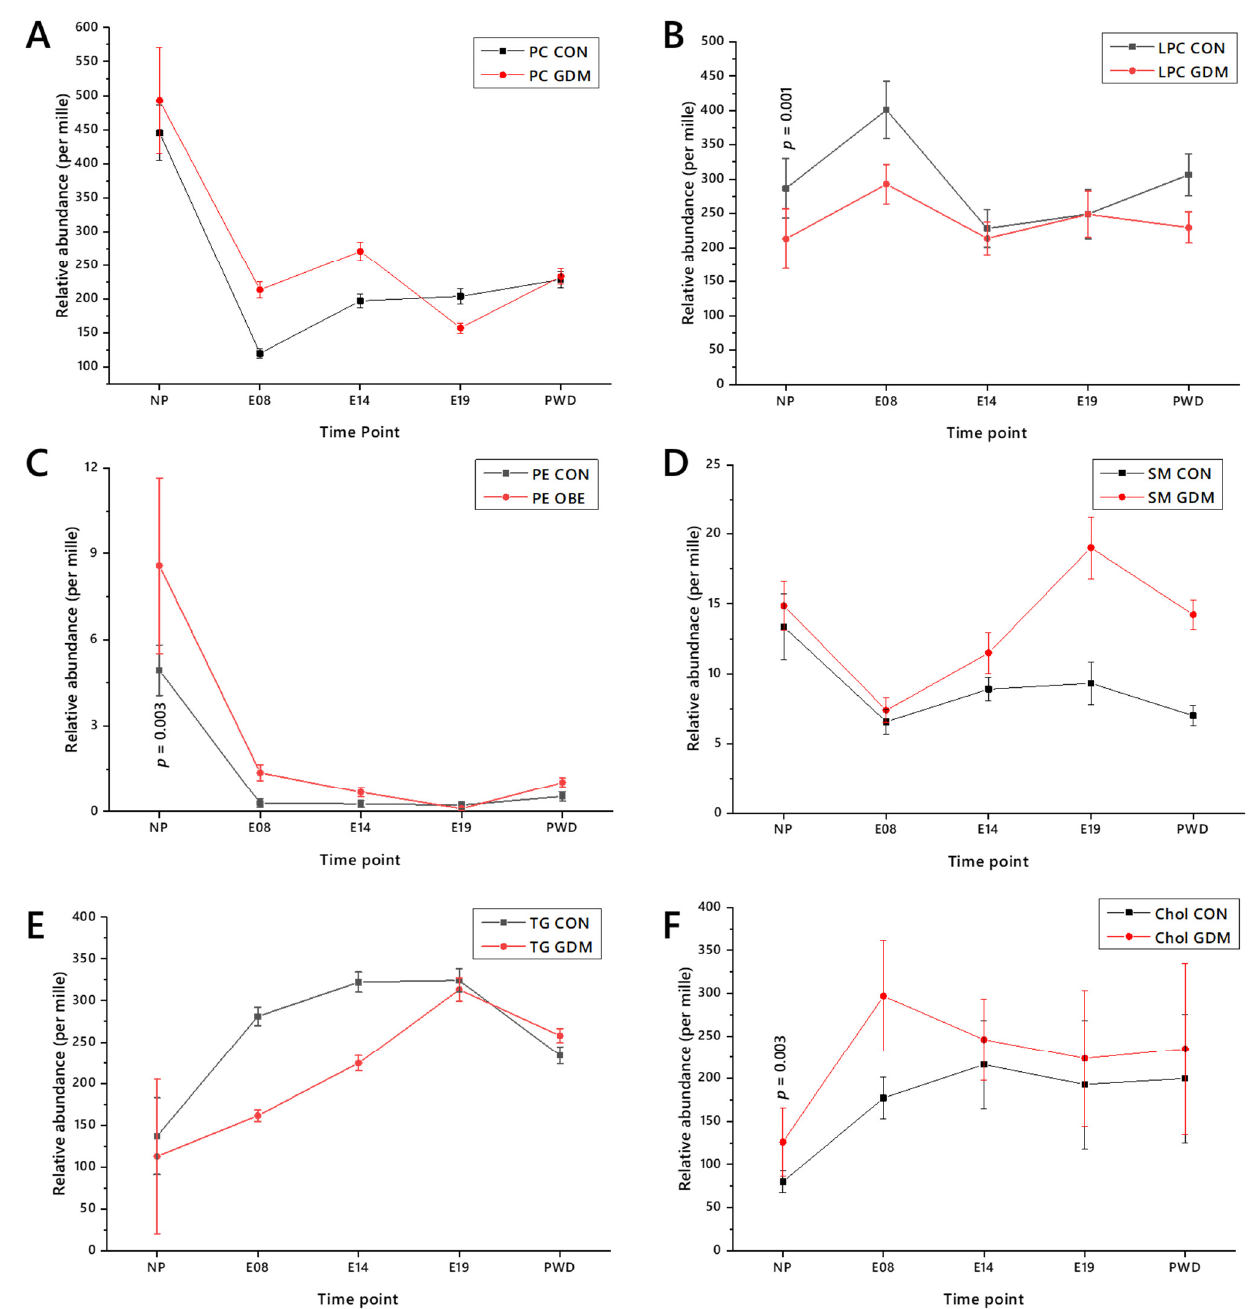
Figure 4. The abundance of lipid classes in the circulation through pregnancy presented as means ± SD. ( Panel A ) Phosphatidylcholine; ( B ) lyso -phosphatidylcholine; ( C ) phosphatidylethanolamine; ( D ) sphingomyelin; ( E ) triglyceride; ( F ) Cholesterol. E08. 8th day of pregnancy; E14, 14th day of pregnancy; E19, 19th day of pregnancy; NP, not pregnant; PWD, post-weaning dam.